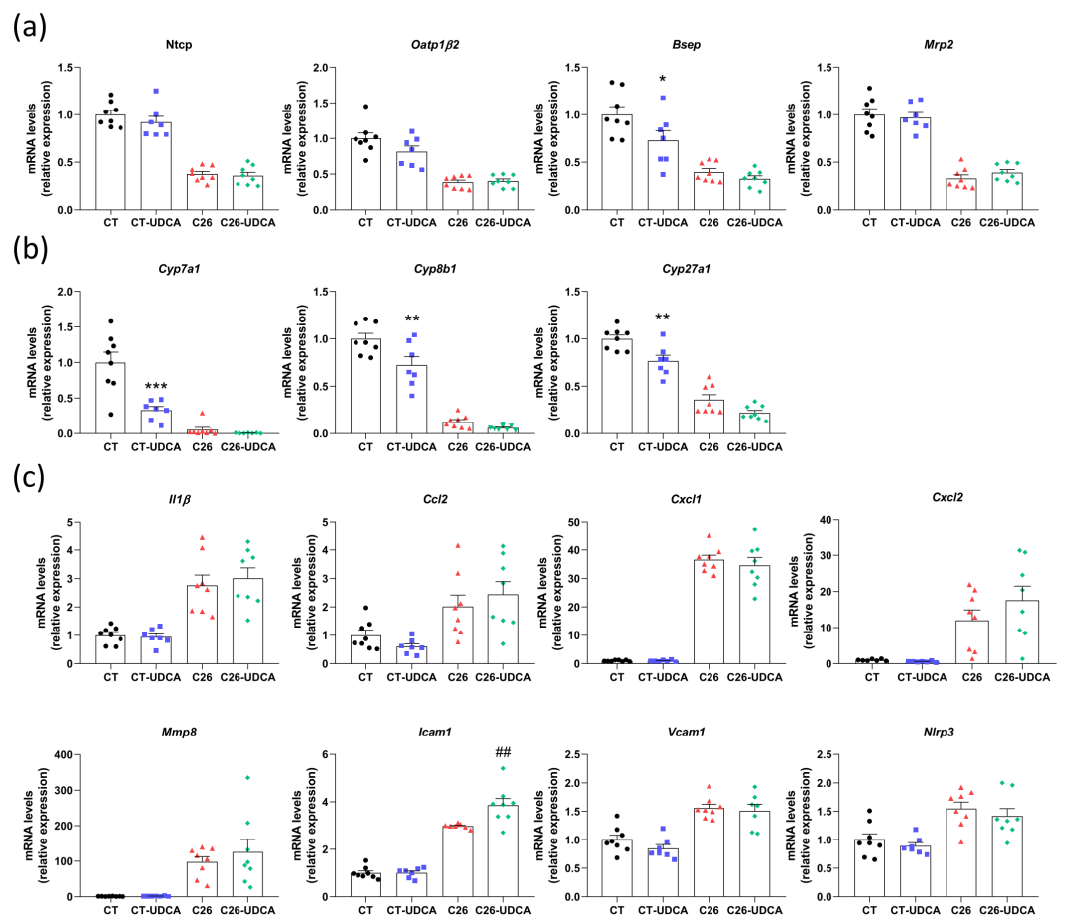
Figure 5. UDCA treatment does not improve hepatic inflammation in C26 cachectic mice. Hepatic mRNA expression levels of genes involved in the hepatobiliary transport system ( a ), bile acid synthesis ( b ) and inflammation ( c ) in sham-injected mice (CT), sham-injected mice treated with UDCA (CT-UDCA), mice injected with cachexia-inducing C26 colon carcinoma cells (C26), and mice injected with cachexia-inducing C26 colon carcinoma cells and treated with UDCA (C26-UDCA). Ntcp , Na(+)/taurocholate transport protein; Oatp1 β 2 , organic anion transporter family member 1B2; Bsep , bile salt export pump; Mrp2 , multidrug resistance-associated protein 2; Cyp7a1 , cytochrome P450 family 7 sub-family A member 1; Cyp8b1 , cytochrome P450 family 8 sub-family B member 1; Cyp27a1 , cytochrome P450 family 27 sub-family A member 1; Il1 β , interleukin-1 β ; Ccl2 , C-C motif chemokine ligand 2; Cxcl1 , C-X-C motif chemokine ligand 1; Cxcl2 , C-X-C motif chemokine ligand 2; Mmp8 , matrix metallopeptidase 8; Icam1 , intercellular adhesion molecule 1; Vcam1 , vascular cell adhesion